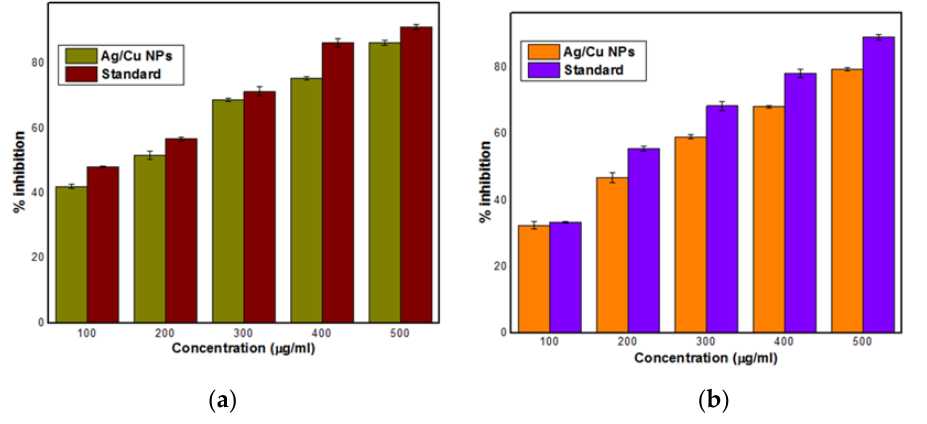
Figure 9. DPPH ( a ) and hydrogen peroxide ( b ) scavenging activity of Ag-Cu NPs (mean and SD, n = 3).